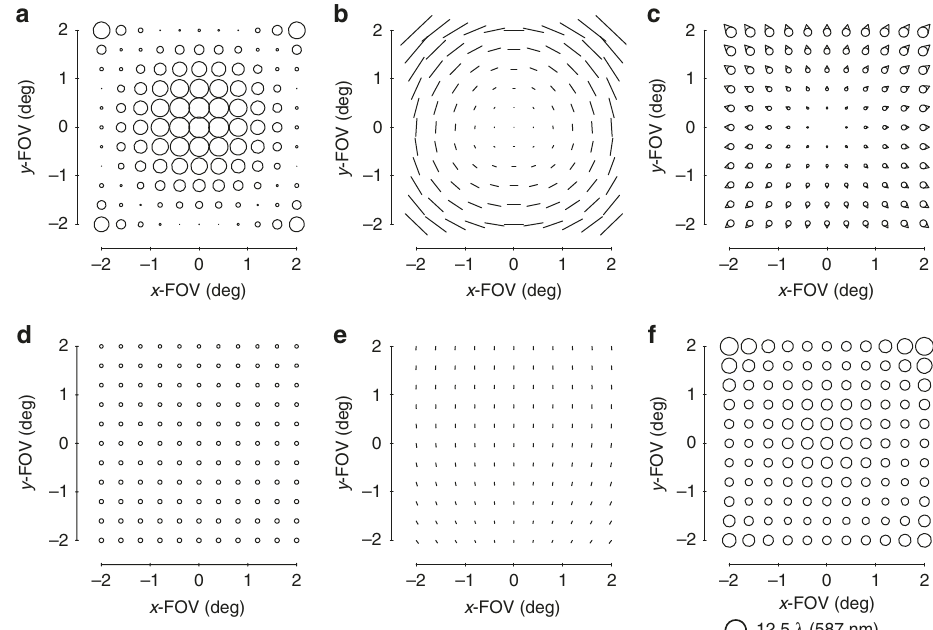
Fig. 4 Zernike-based aberration FFDs after a coma surface. After adding a coma shape to the primary and tertiary mirrors and allowing a slight tilt of the image plane, the aberrations of the system were calculated and are shown in FFDs for a defocus (Z4), b astigmatism (Z5/6), c coma (Z7/8), d spherical aberration (Z9), e elliptical coma (Z10/11), and f root-mean-square wavefront error (RMS WFE). Note the scale decreased 10× from Fig.